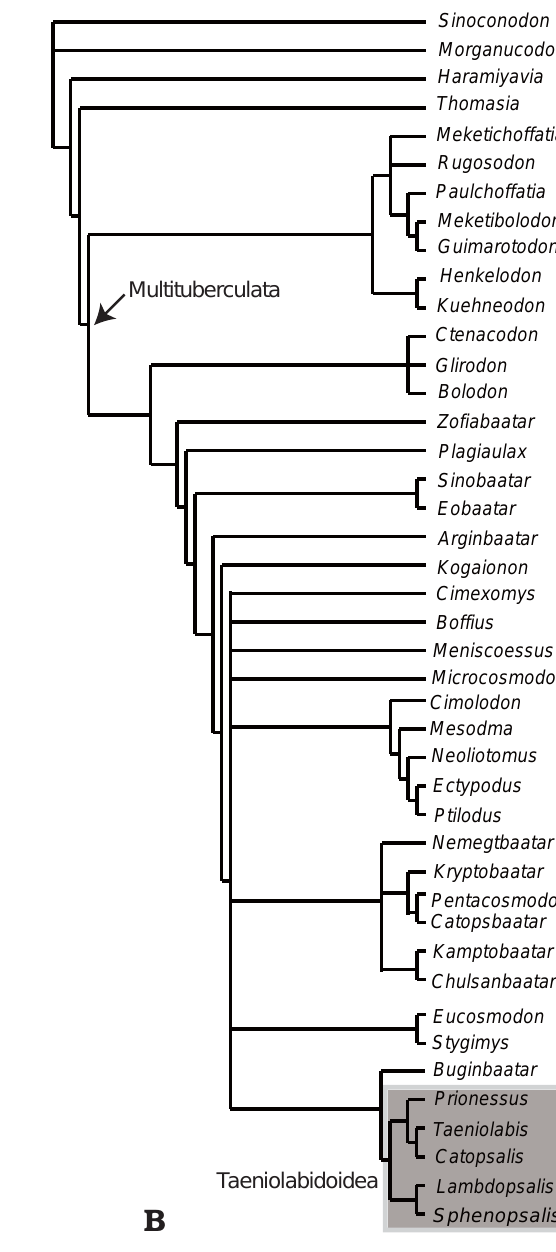
Fig. 17. Phylogenetic position of Sphenopsalis nobilis within multituberculates. A . The strict consensus tree of 138 trees obtained in the PAUP search where 19 characters were ordered (see SOM). B . The 50% majority rule consensus tree with 19 characters ordered. See additional supporting data in the